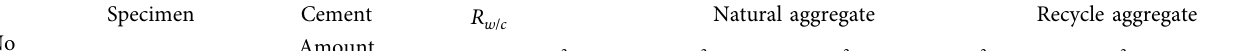
Figure 5: Rapid chloride migration specimens test. (a) Prepared samples. (b) RCM test equipment. (c) Tested samples. Table 3: Mix proportion, basic parameters of experimental